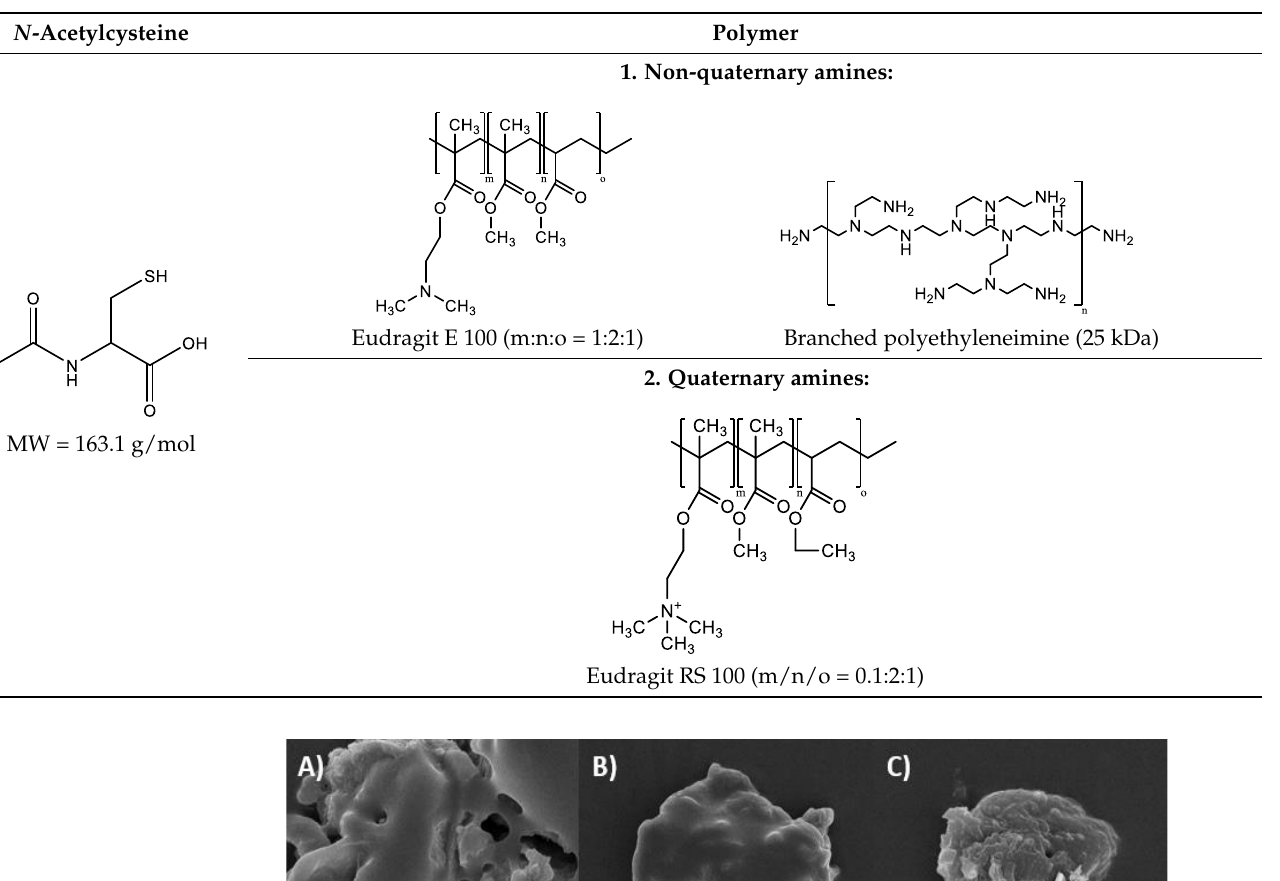
Figure 1. SEM images: ( A – C ) Characterizing NAC polymer ionic complexes with PEI, Eudragit E 100, and Eudragit RS 100, respectively.